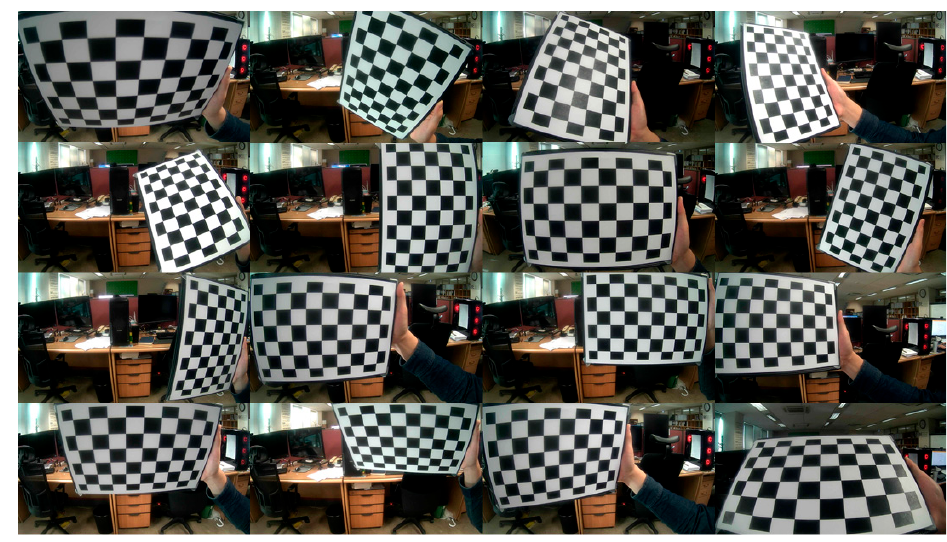
Figure 9. Image for internal calibration of SNO-6084R CCTV.